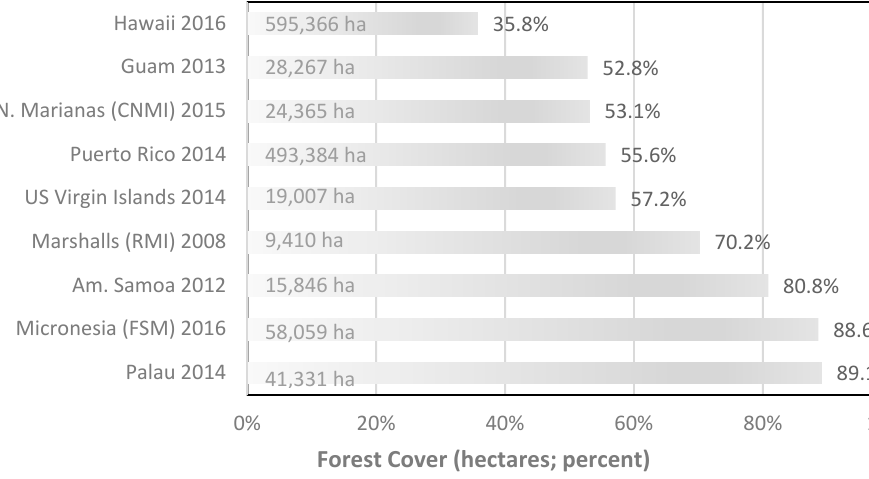
Figure 2. Forest cover in hectares and as a percentage of total land area for U.S. and U.S.-affiliated tropical islands (CNMI: Commonwealth of Northern Mariana Islands, RMI: Republic of Marshall Islands, FSM: Federated States of Micronesia) Source: [30].